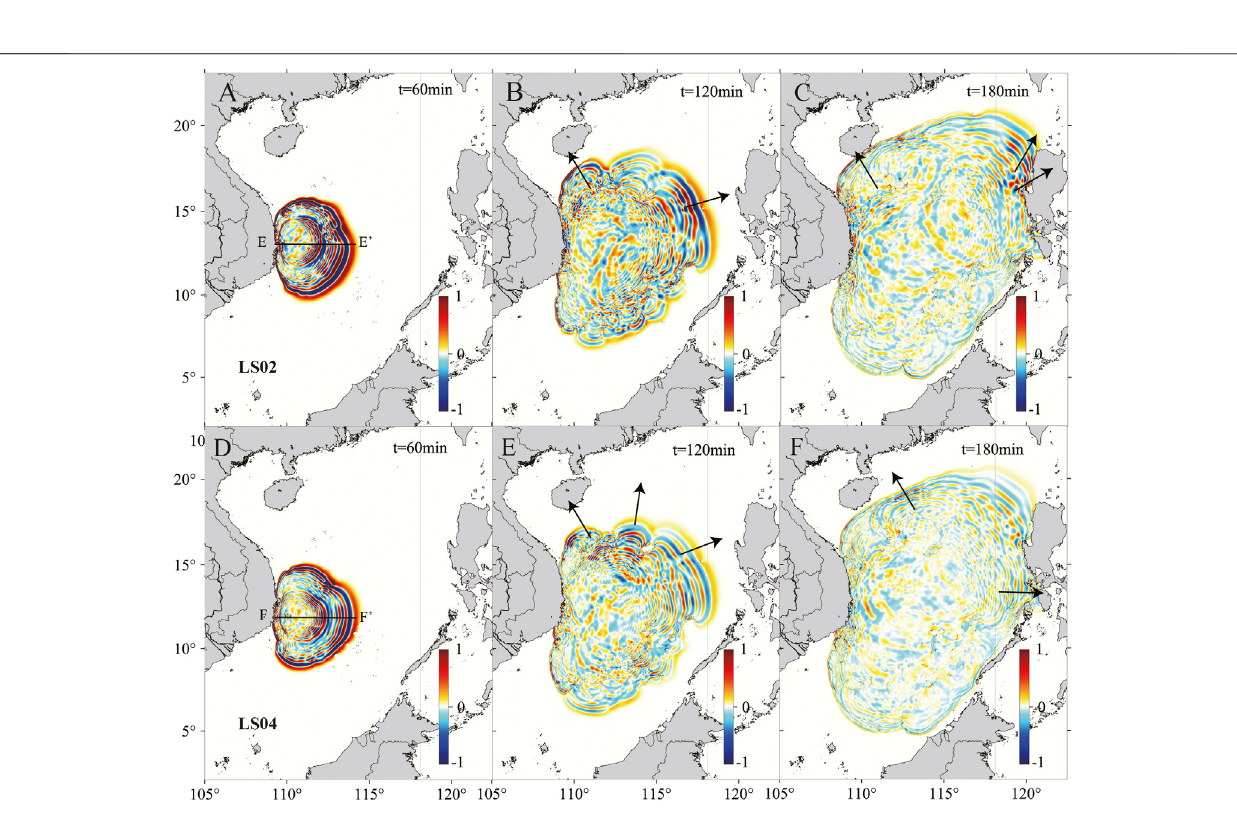
Frontiers in Earth Science |